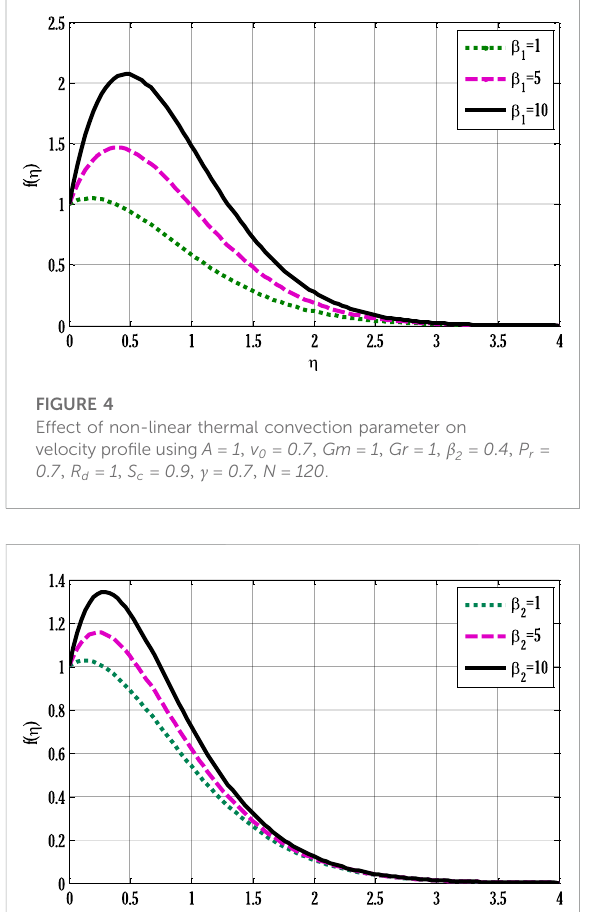
FIGURE 8 Effect of Schmidt number on concentration pro fi le using A (cid:1) 1